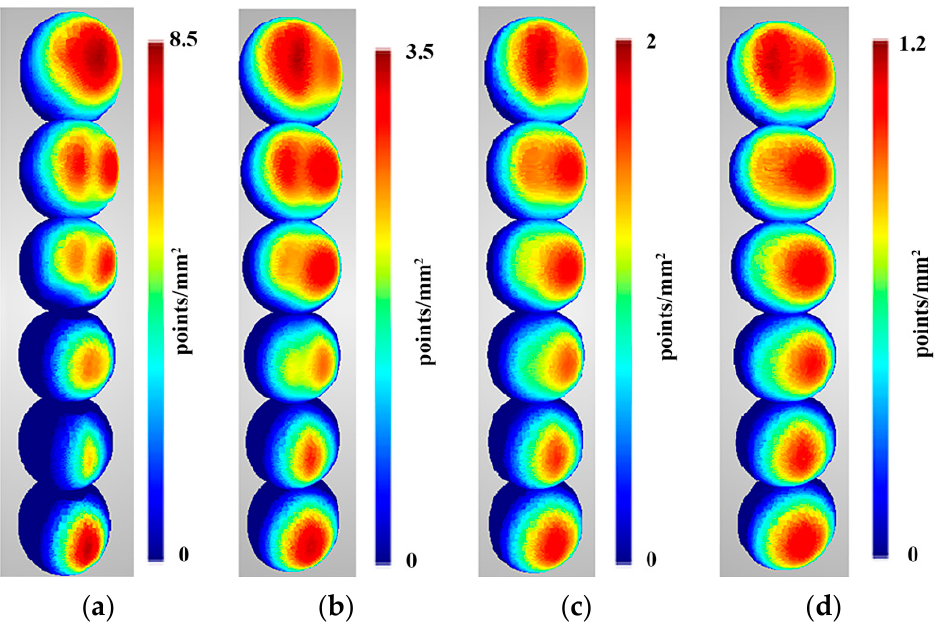
Figure 10. Density evaluation of the reconstructed sphere at the following distances: ( a ) 2 m, ( b ) 3 m, ( c ) 4 m, and ( d ) 5 m. Spheres in different rows were reconstructed from scenarios with different numbers of cameras. In order from bottom to top, these were as follows: two-, three-, four-, six-, nine-, and twelve-camera scenarios.